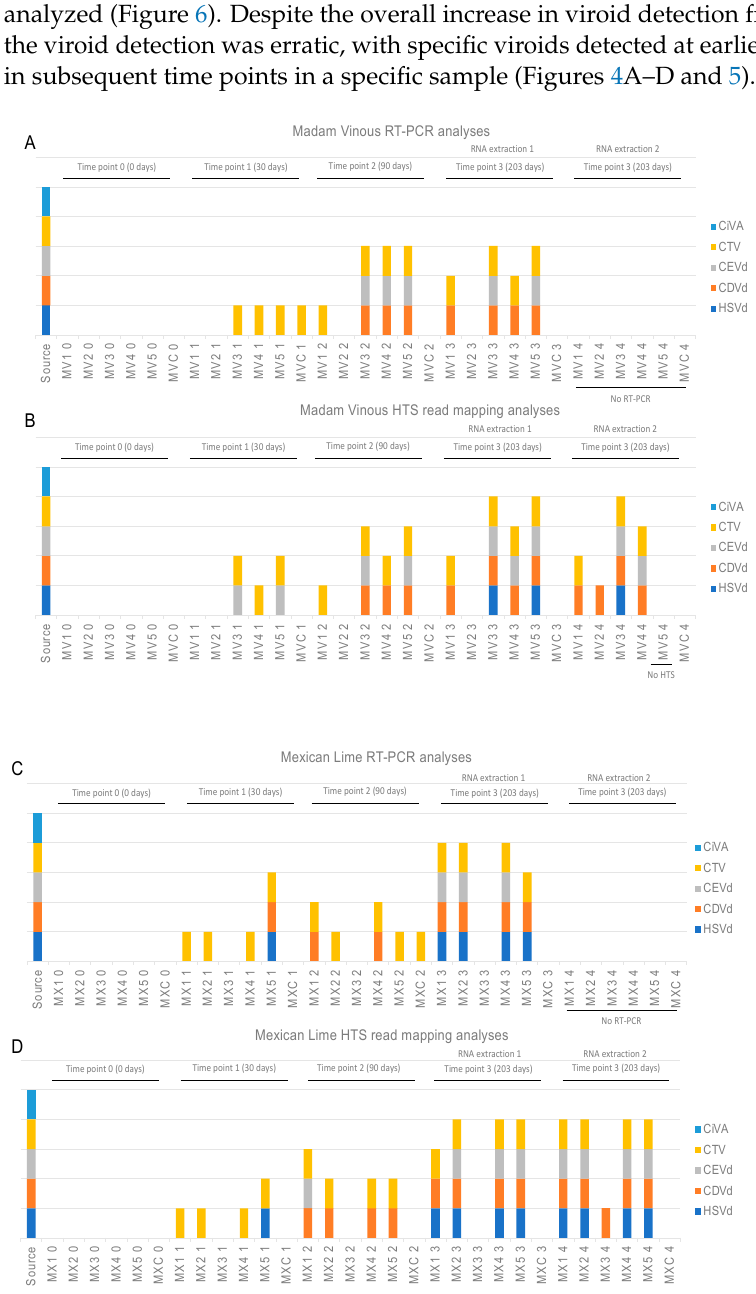
Figure 4. Stacked column chart displaying the virome profile of Madam Vinous ( A , B ) and Mexican Lime ( C , D ) plants at different time points constructed with RT-PCR ( A , C ) and HTS read mapping analyses ( B , D ). Each column represents a plant (MV1–5 or MX1–5) from which RNA was extracted 5 times (0–4). Extractions 3 and 4 were extracted both on 203 days post inoculation, but with different RNA extraction methods (RNA extraction 1: CTAB with LiCl precipitation; RNA extraction 2: CTAB extraction with ethanol precipitation). Samples MVC and MXC represent the healthy controls. Sample MV5 (extraction 4) was not evaluated with HTS. Samples MV1–5 (extraction 4) and samples MX1–5 (extraction 4) were not evaluated with RT-PCR (CTV: citrus tristeza virus; CiVA: citrus virus A; HSVd: hop stunt viroid; CDVd: citrus dwarfing viroid; CEVd: citrus exocortis viroid). The geometric mean of the reference genes’ TPM values, obtained by mapping the HTS data to the 12 C. sinensis reference genes, was used to normalize the TPM value of each pathogen to calculate a relative pathogen-specific concentration to compare between samples. For both the ‘Mexican Lime’ and ‘Madam Vinous’ plants, there was a gradual increase over time in pathogens detected at each time point as the different pathogen infections established in the plant over time (Figure 5). The direct comparison between two different RNA extractions from the same plant material at 203 days post inoculation (time point 3) showed that RNA extraction can have an impact on the detection of viroids with HTS (Supplementary File S3, Figure 6). The same viroid profile was detected in both